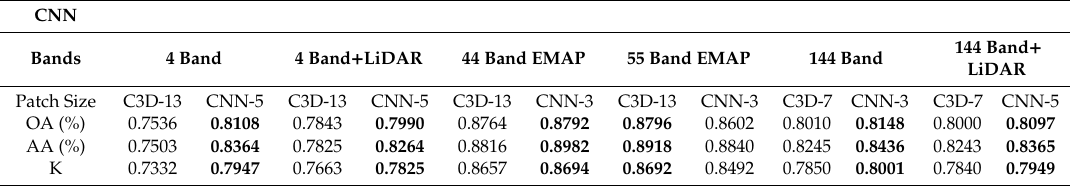
Table 4. Classification performance comparison of the two deep learning methods for the test dataset with six di ff erent image band sets (best performances are highlighted in bold for each image band